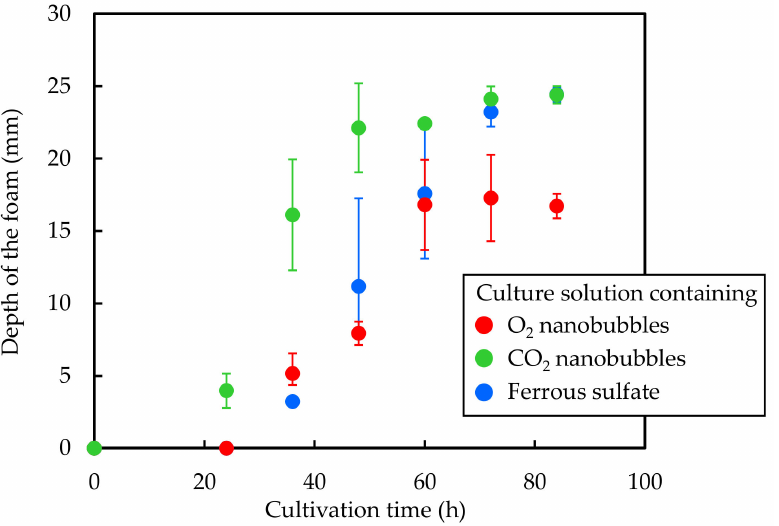
Figure 5. The temporal changes in the depth of the foam phase in each culture medium.